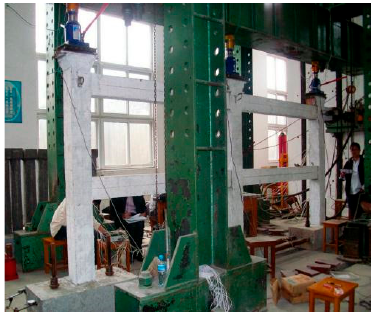
Figure 5. Loading device of the